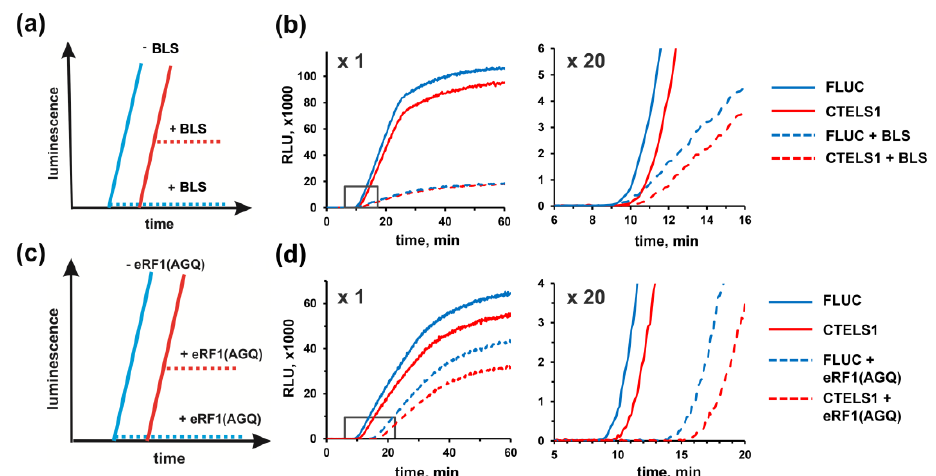
Figure 2. Examination of low- and high molecule weight inhibitors by the CTELS approach. ( a ) Theoretical prediction of blasticidin S (BLS) effects on FLUC and CTELS1 translation, considering the drug specifically inhibits termination. When the compound was added to the cell-free system programmed by FLUC (blue curves), it should suppress its translation due to inhibition of peptide release, while its addition to the mixture with CTELS mRNA (red curves) should not affect the luciferase activity yield at the initial step, until all enzyme molecules synthesized by pioneering ribosomes are completed; only after that CTELS mRNA translation should be also locked, resulting in a plateau in the curve. ( b ) Luciferase activity produced by translation of capped and polyadenylated FLUC and CTELS1 mRNAs in RRL. Representative curves of three independent experiments are shown. ( c ). Theoretical prediction of eRF1(AGQ) effects on FLUC and CTELS1 translation, considering the protein specifically inhibits termination. ( d ) Results of an experiment with the same reporter mRNAs as in ( b ) with addition of 25 ng/ μ L of the eRF1 mutant (dotted curves) or buffer (solid curves).